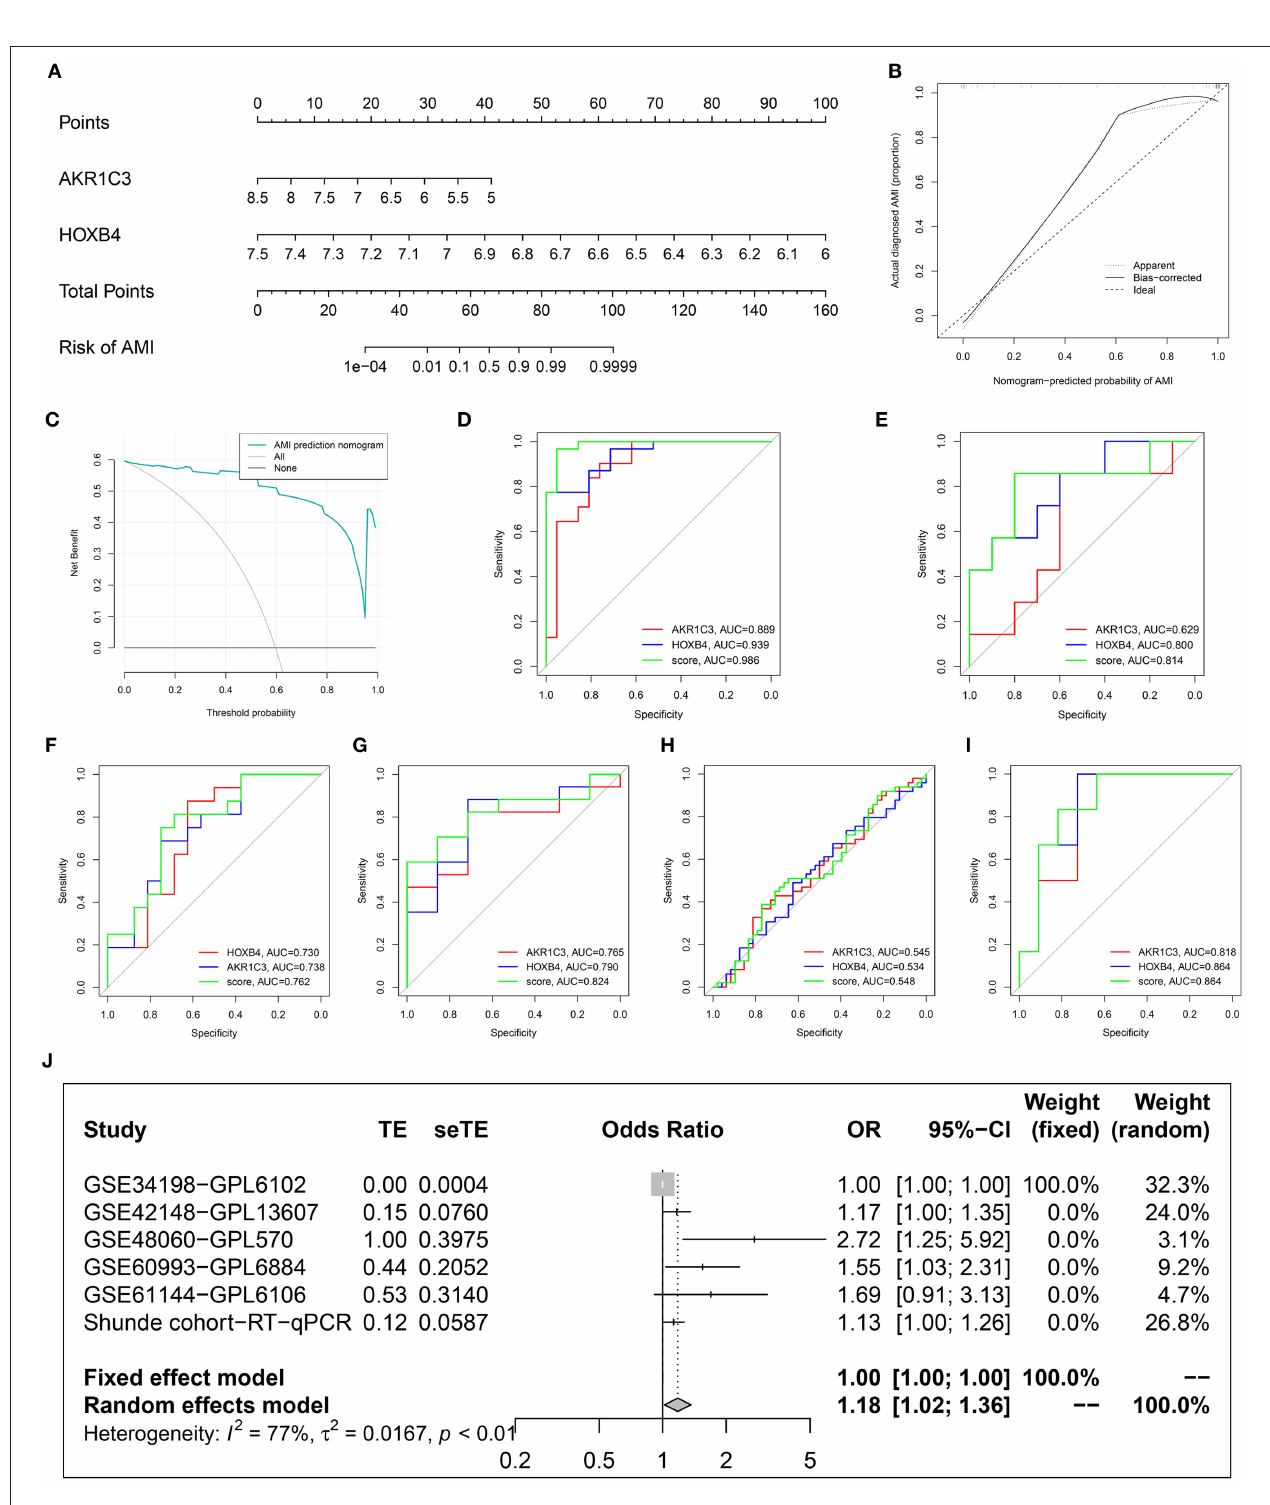
FIGURE 7 | Construction and validation of a diagnostic model. (A) The established nomogram. (B) Calibration plot. (C) Decision curve analysis. (D–I) Receiver operating characteristic analysis in GSE48060 (D) , GSE61144 (E) , Shunde cohort (F) , GSE60993 (G) , GSE34198 (H) , and GSE42148 (I) . (J) Meta-analysis.